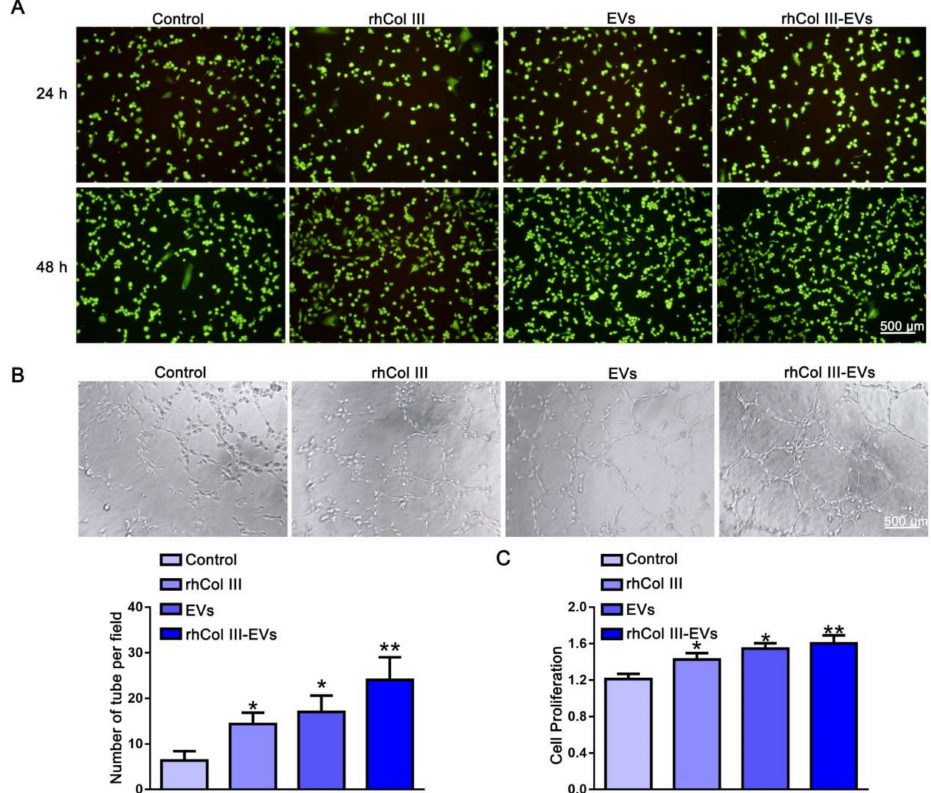
Figure 4. The effect of rhCol III-EVs on the angiogenesis of HUVECs. ( A ) Live/dead analysis of HUVECs in different groups ( n = 3). ( B ) Angiogenesis of HUVECs in different groups ( n = 3, * p -value < 0.05 vs. Control group, ** p -value < 0.01 vs. Control group). ( C ) Proliferation of HUVECs in different groups ( n = 3, * p -value < 0.05 vs. Control group, ** p -value < 0.01 vs. Control